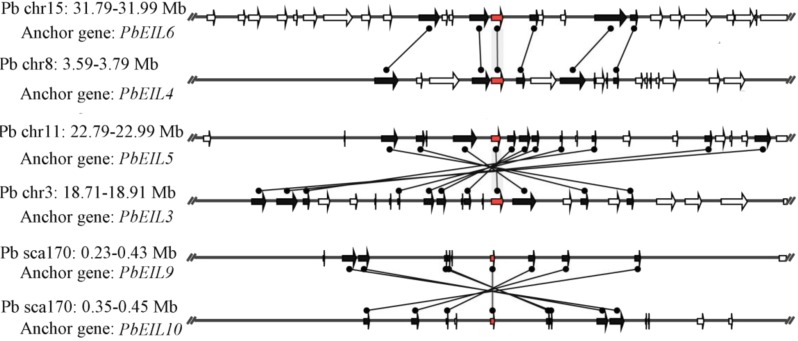
Intraspecific microsynteny related to EIN3/EIL families with the same species.The relative positions of all flanking protein-coding genes were defined by anchored EIN3/EIL genes, highlighted in red. The gene’s orientations are shown as triangle, with gray lines corresponding to chromosomal segments.